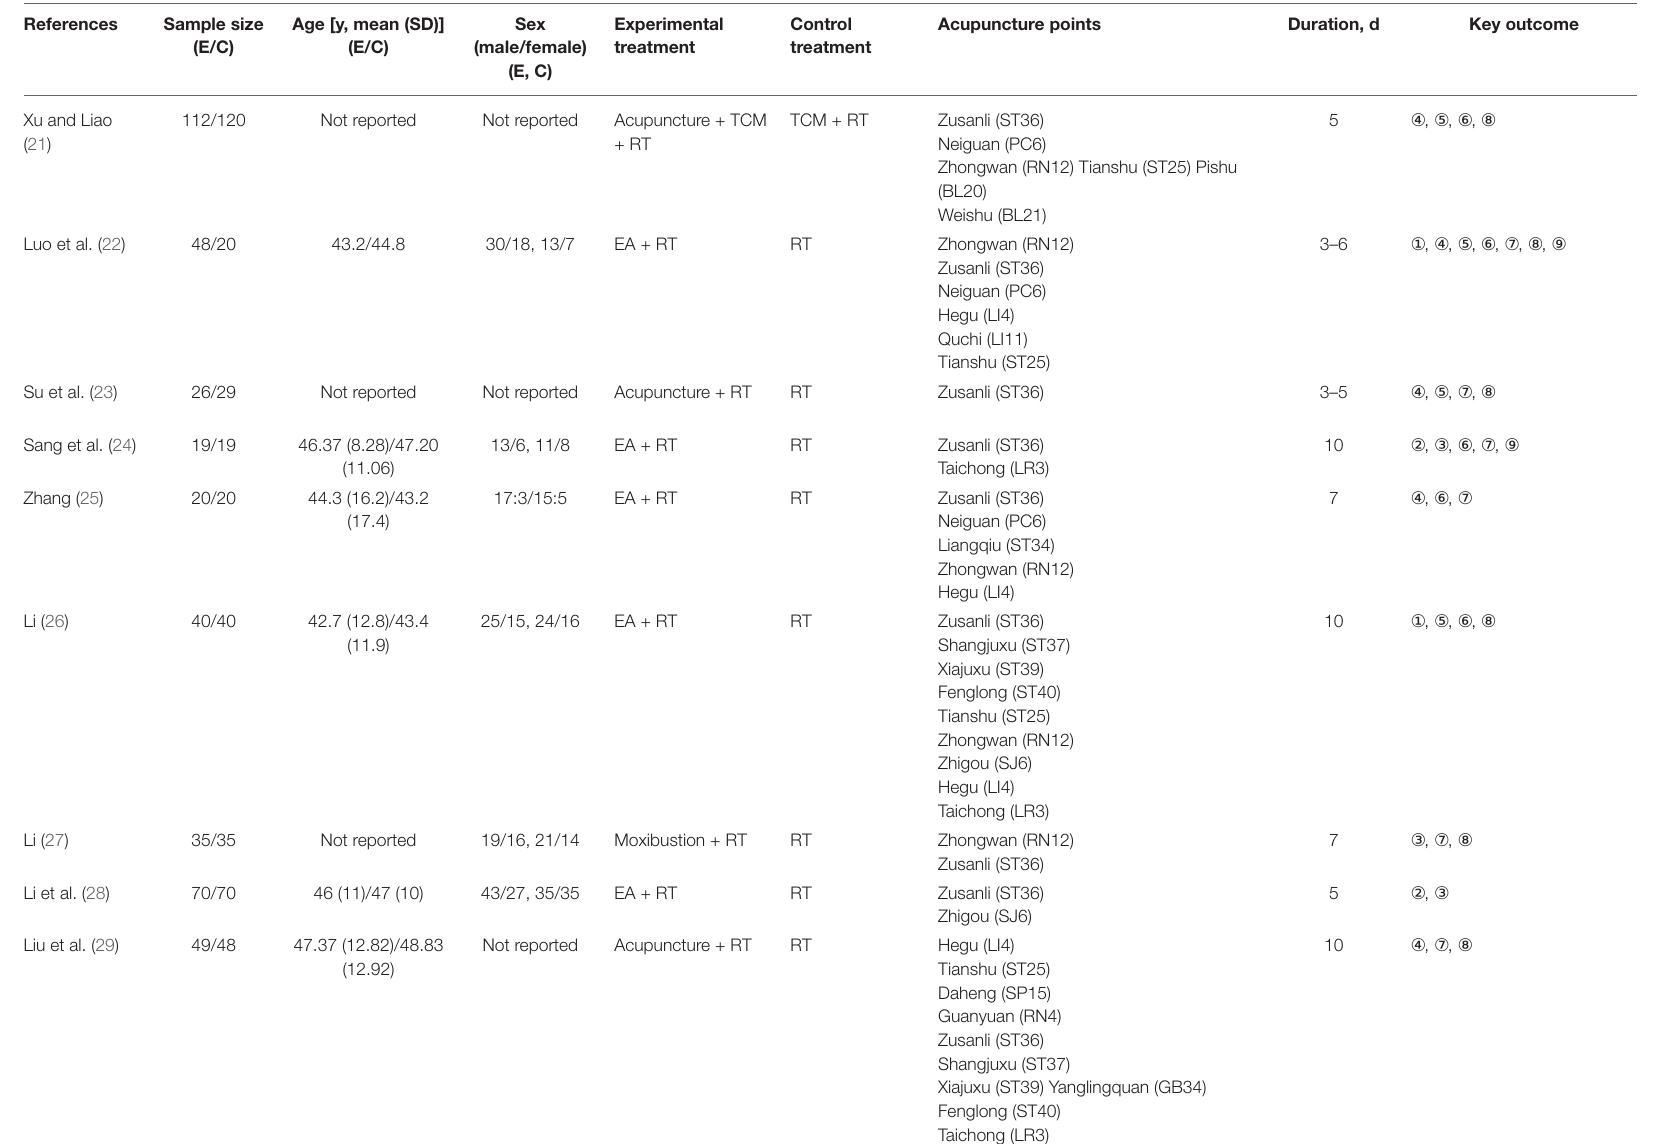
TABLE 1 | Characteristics of the included